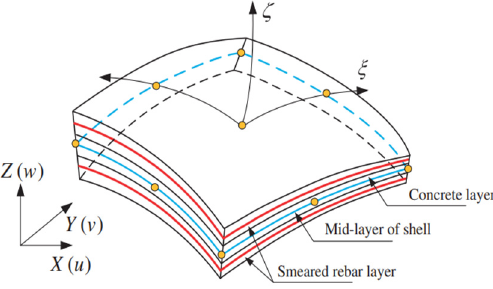
Figure 7. Shell element with a layered shell section model.